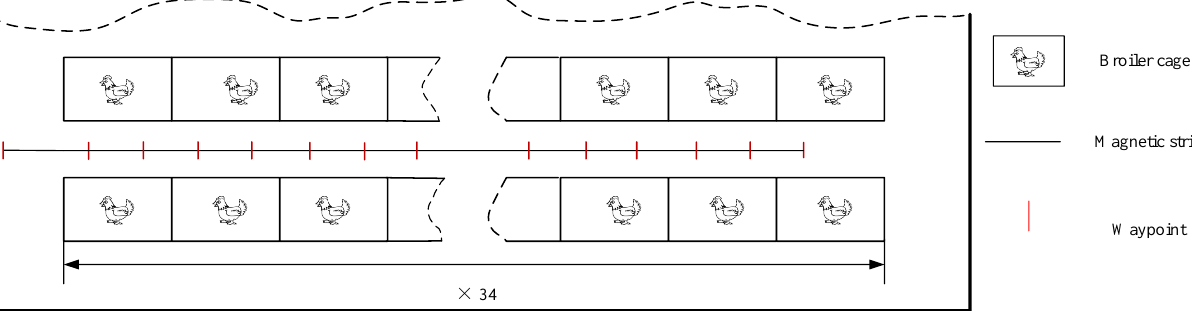
Figure 6. Image acquisition waypoint in an aisle.